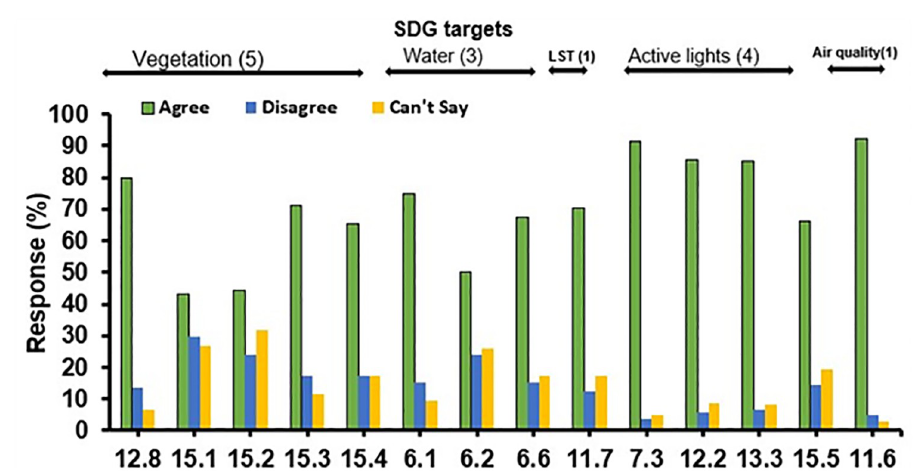
Fig 6. The percentage share of expert responses for each UN-SDG target under different urban environmental categories.